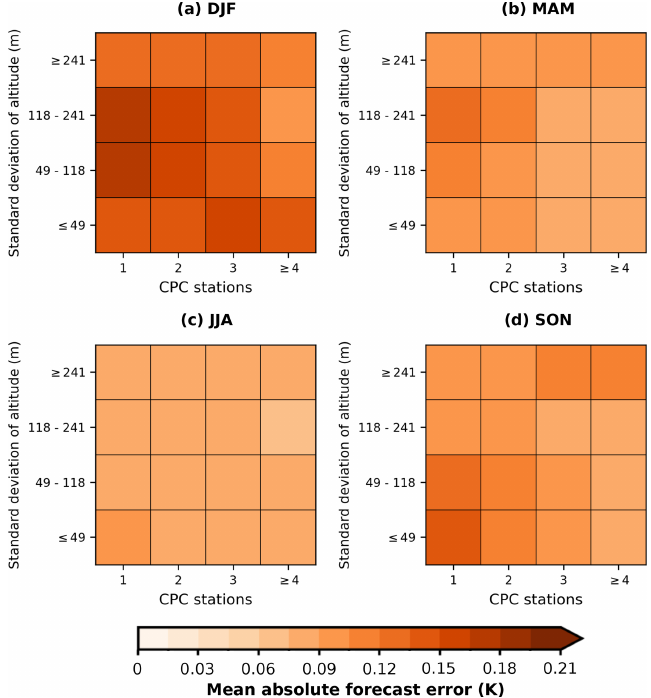
Figure A2. Heat maps of forecast error according to the number of CPC stations around the grid cells ( x axis) and the quartiles of standard deviation of altitude in the grid cells ( y axis).